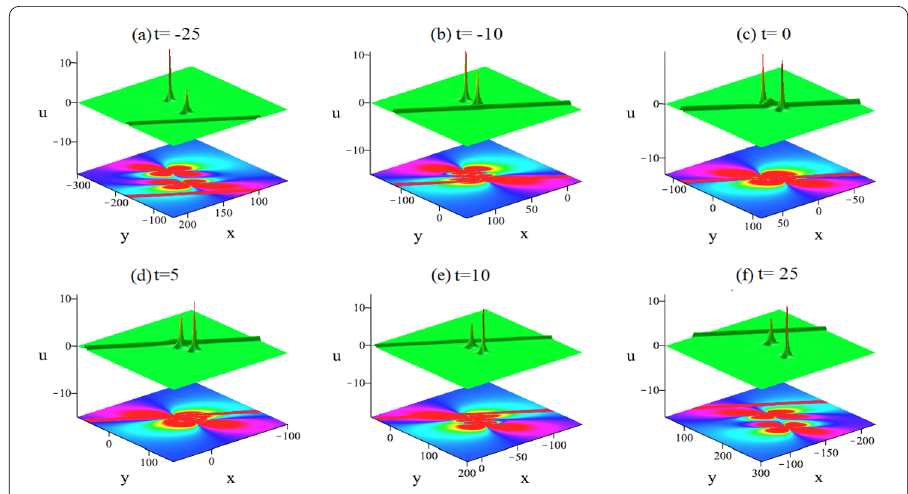
Figure 6 The interaction solution between one line soliton and two lumps at different time and parameters in Eq.